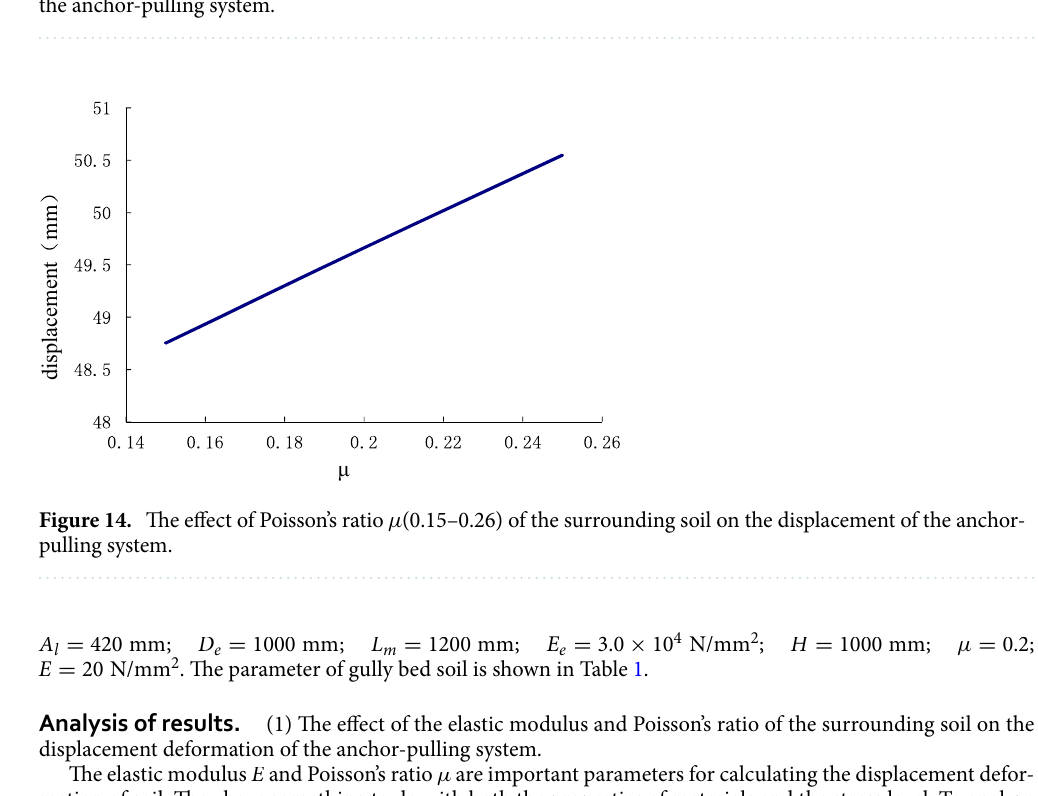
Figure 13. The effect of the elastic modulus E (15–45 N/mm 2 ) of the surrounding soil on the displacement of the anchor-pulling system.